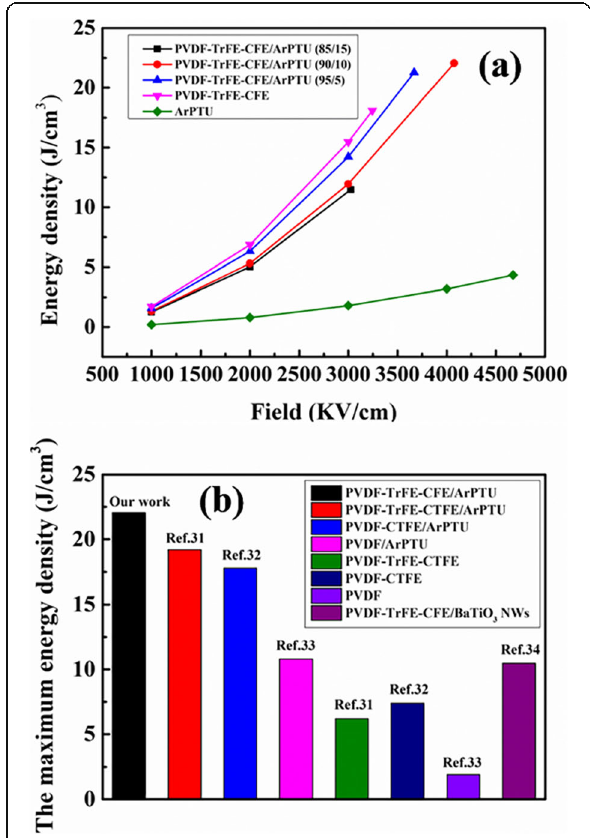
Fig. 10 a The energy density of PVDF-TrFE-CFE/ArPTU composite films with different composite ratios. b Comparing of discharge energy density of our works with reported works [39,